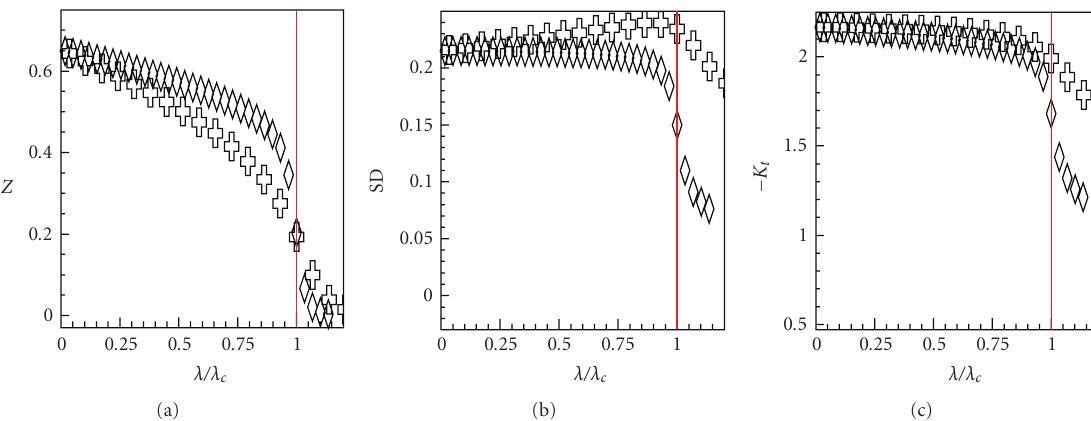
Figure 12: (a) Spectral weight, (b) spin deviation (b), and (c) average kinetic energy of mediated by magnons near neighbor transitions for g 1 = 0 (diamonds) and g 1 = 0 . 5 g (crosses). Other parameters are J/t = 0 . 4, ω 0 /t = 0 . 2, t (cid:2) = − 0 . 5 t , t (cid:2)(cid:2) = 0 . 4 t , and N = 4 × 4 = 16. Critical λ c is set at such coupling where the spectral weight of the ground state reaches 0.3 of the unrenormalized by EPI weight.